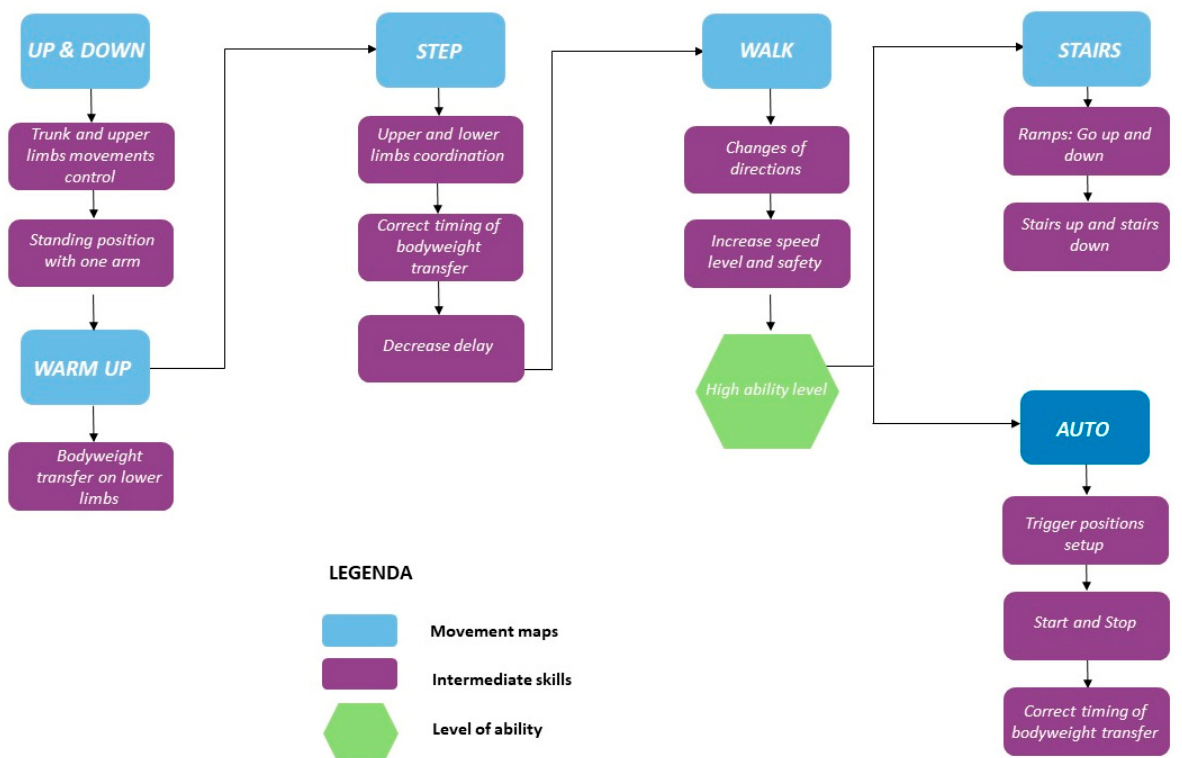
Figure 2. UAN.GO ® protocol; the training was divided in two moments: during pre-walk training four abilities were gained: up and down (sitting and standing), step (load transfer), walk (acquisition of physiological gait phase), stairs (climbing up and down ramps) . With all abilities acquired, the patient started an intensive walk phase, to achieve the best change in step and swing parameters.